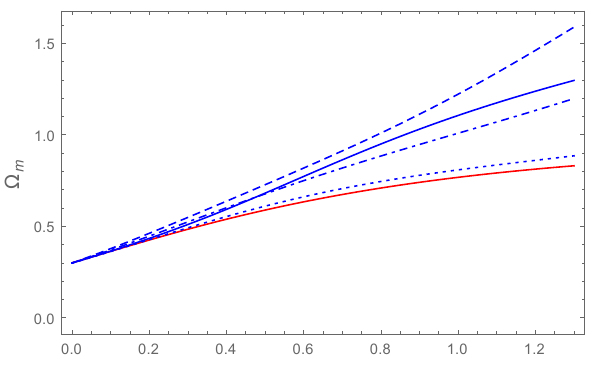
(cid:0) (cid:1) β 2 R µν + β 3 T µν with